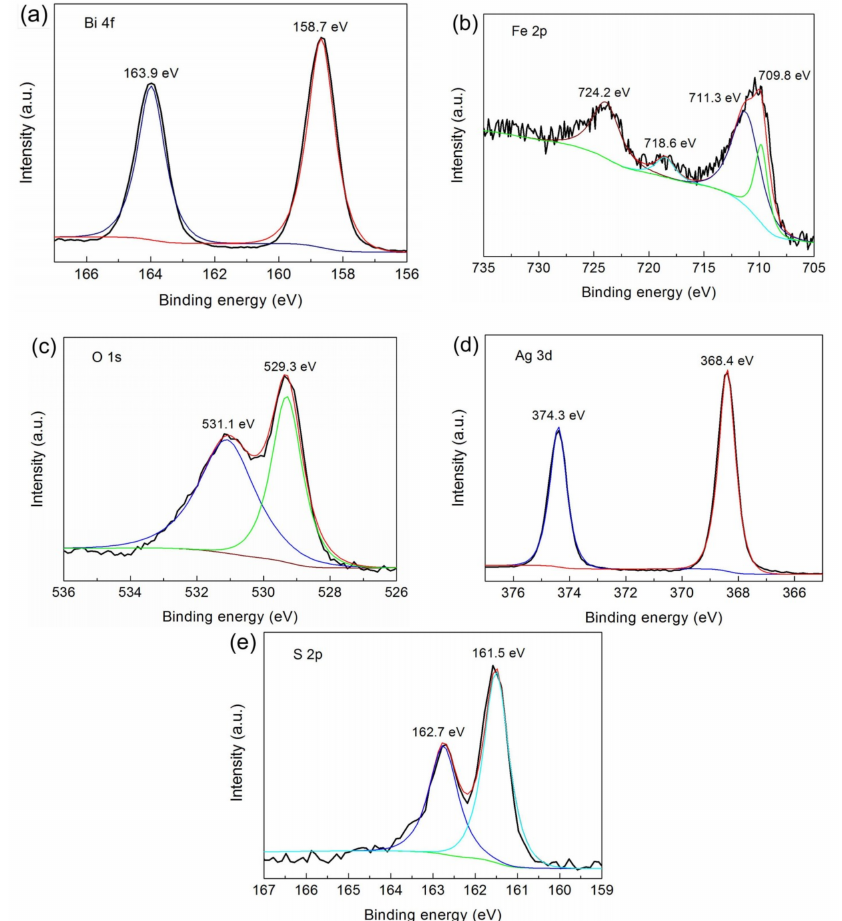
Figure 3. High-resolution X-ray photoelectron spectroscopy (XPS) spectra of the 15% Ag 2 S/BiFeO 3 composite. ( a ) Bi 4f; ( b ) Fe 2p; ( c ) O 1s; ( d ) Ag 3d; ( e ) S